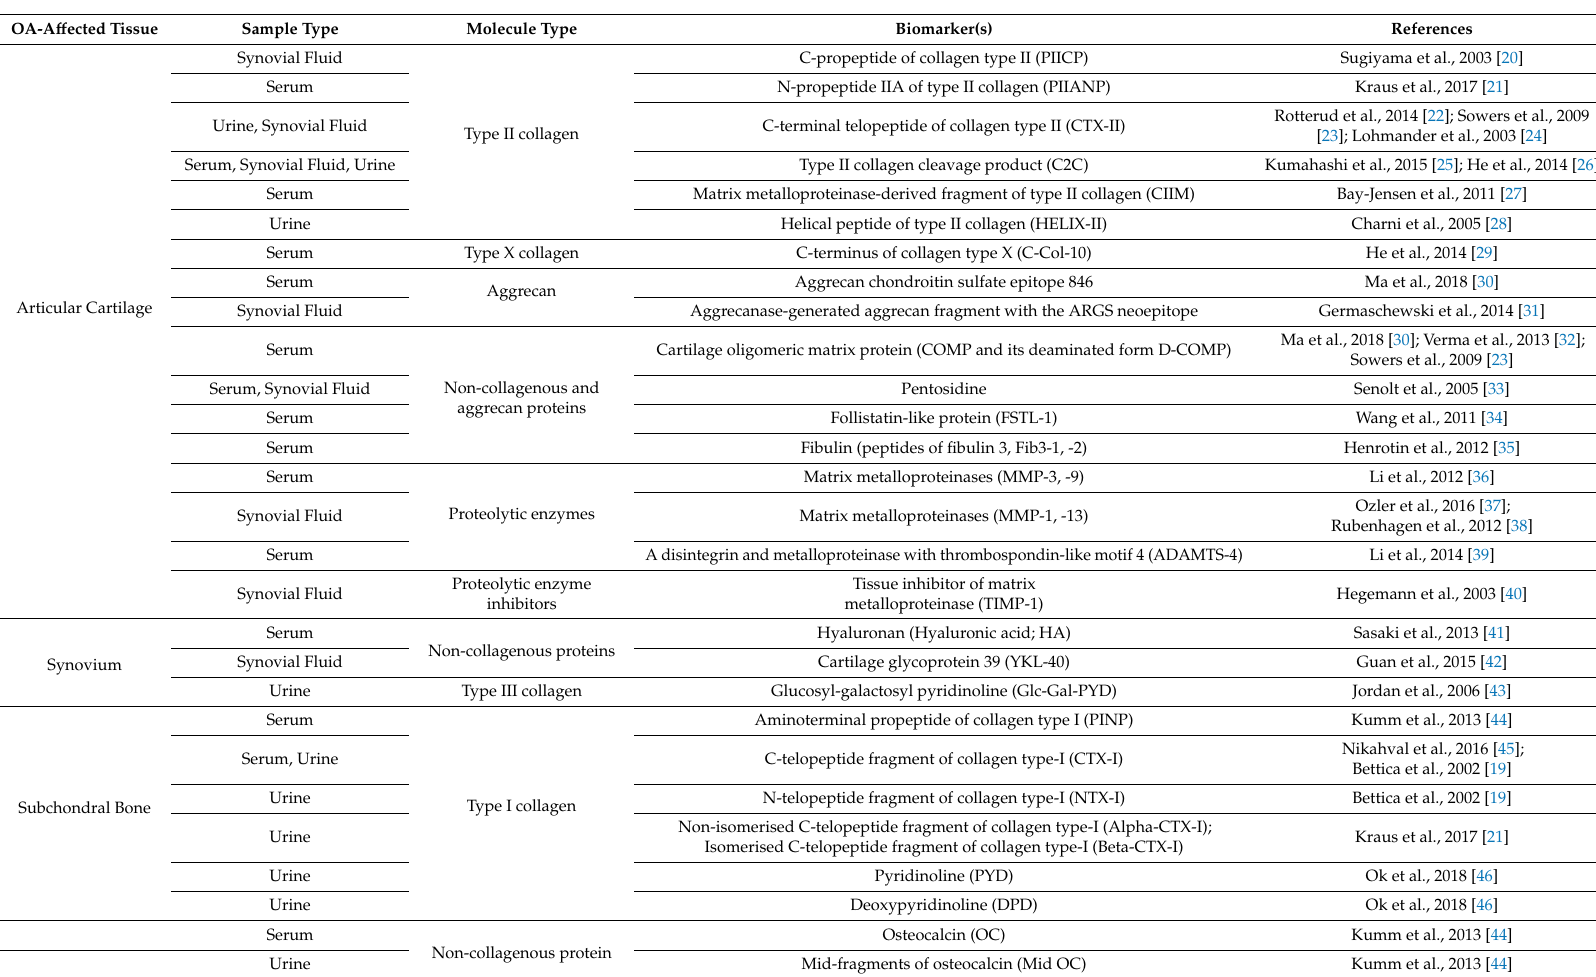
Table 1. Potential biomarkers currently being investigated for the evaluation of osteoarthritis (OA) and presumed pathological process, measured from synovial fluid, serum or